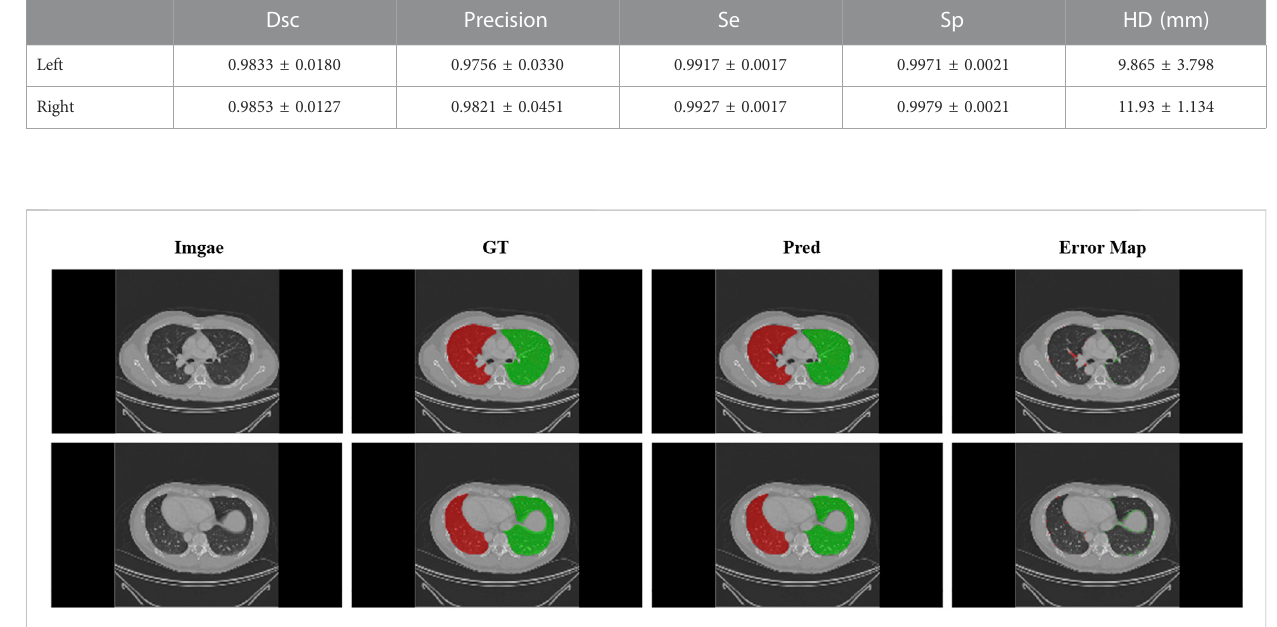
FIGURE 3 Display of lung segmentation results. Green areas: left lung; Red areas: right lung. Error map that performed the difference between the predicted and real results is